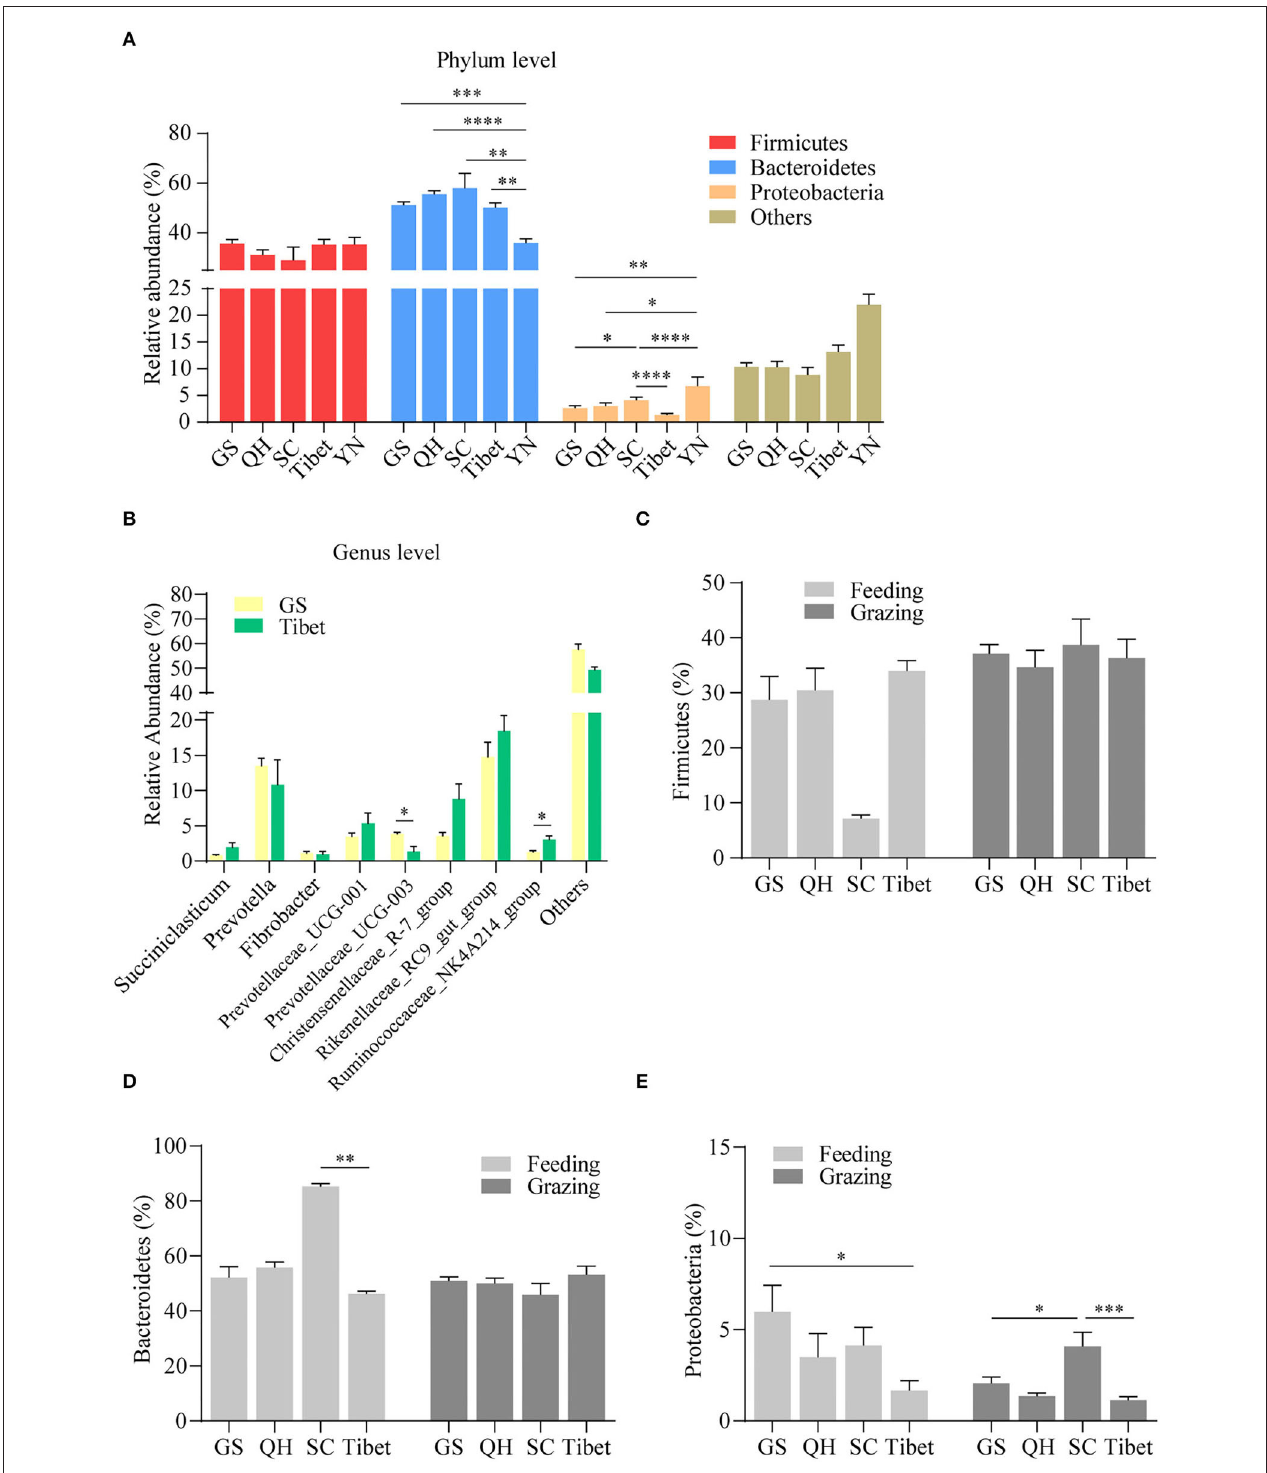
FIGURE 4 | Regional influence on yak rumen microbiota. The relative abundance of phylum (A) and genus levels (B) in rumen microbiota in different provinces was compared, irrespective of the method of yak husbandry. Comparison of the relative abundance of the Firmicutes (C) , Bacteroidetes (D) , and Proteobacteria (E) in different provinces under the method of grazing vs. feeding. The data were expressed as mean ± SEM. The Mann–Whitney test was applied for intragroup comparison, whereas the Kruskal–Wallis test with post hoc Dunn’s test was used for intergroup comparison. * p < 0.05, ** p < 0.01, *** p < 0.001, **** p < 0.0001. GS, Gansu province; QH, Qinghai province; SC, Sichuan province; YN, Yunnan